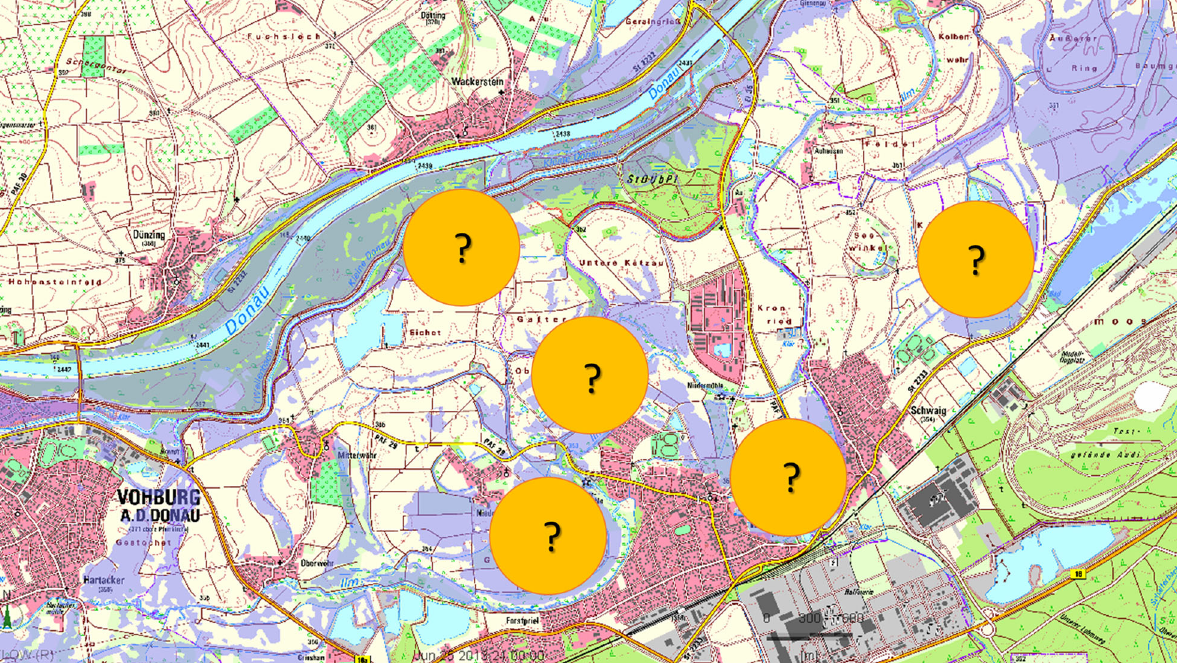
Fig. 6 Model calibration based on local knowledge and data generated through interaction between local residents and modeling experts at the DIALOGIK round table of 7 March 2017 in Mu¨nchsmu¨nster, Bavaria. The question marks represent the areas where local knowledge was successfully used for